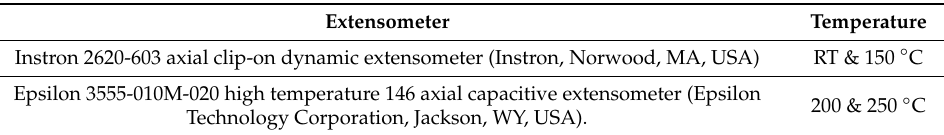
Table 3. Extensometers used.